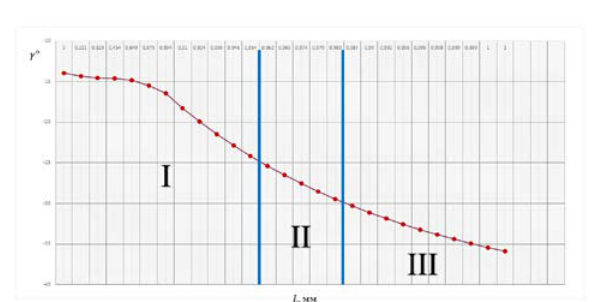
Fig. 3. Variation of normal rake angle on toroidal forming surface from mill’s face on XOY grafic plot